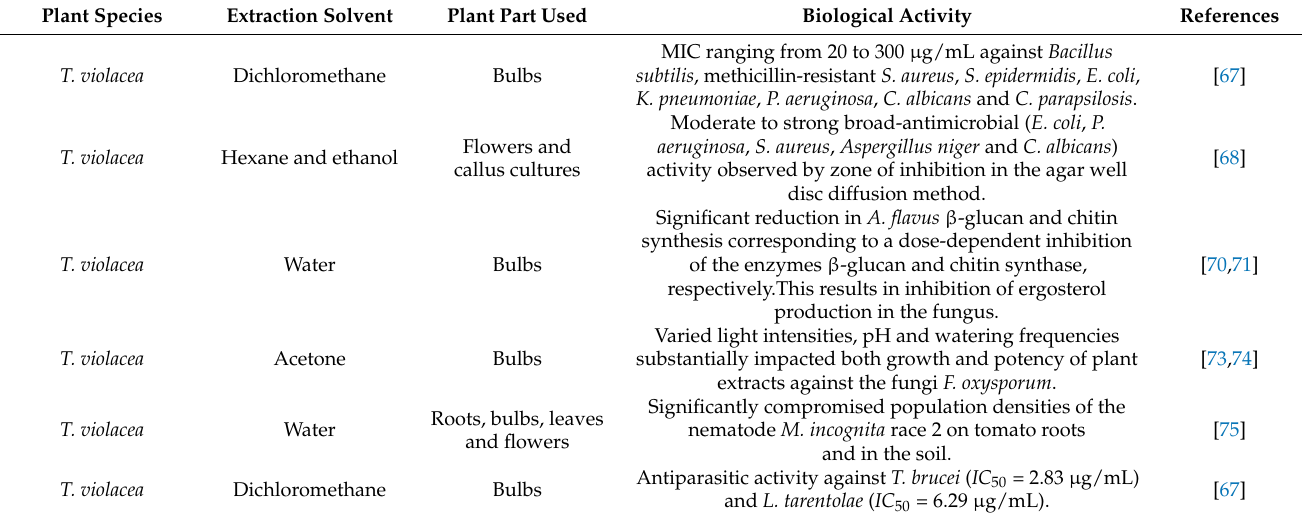
Table 4. Antimicrobial activity of Tulbaghia